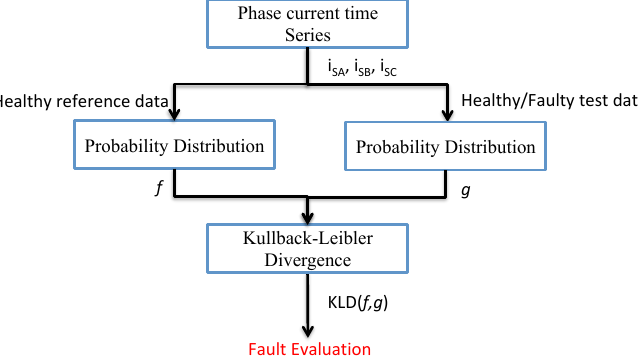
Figure 16. Flowchart for application of the